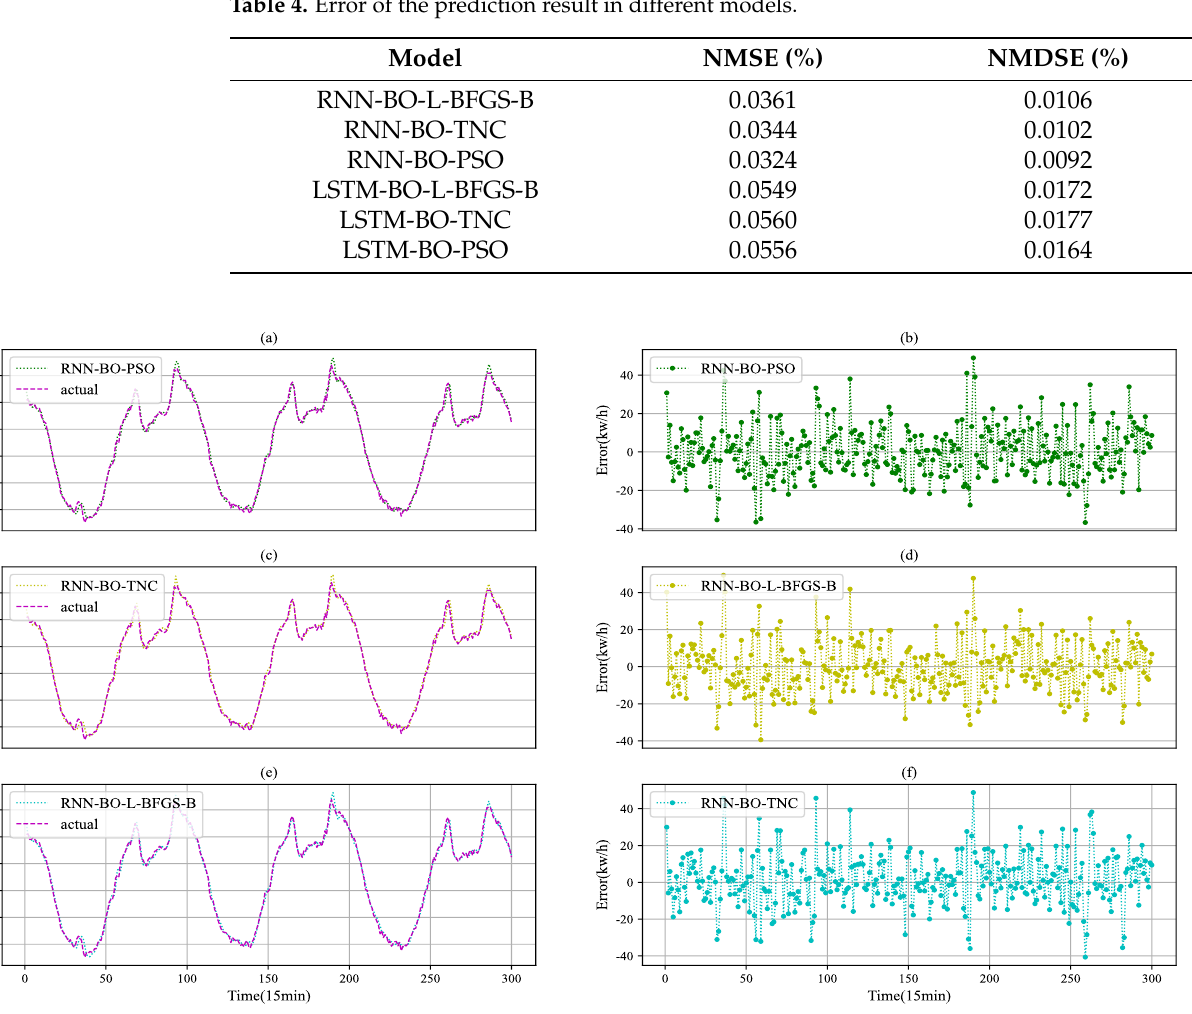
Figure 6. Load prediction for RNN. ( a , c , e ) The load fitting curves for RNN. ( b , d , f ) The load prediction error curves for RNN, which are obtained by subtracting the measured values from the predicted values. And the error curves correspond to the left fitting curves